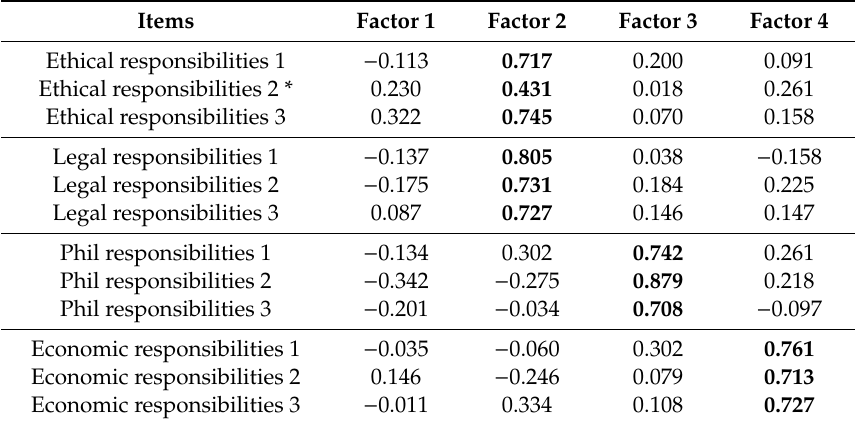
Table 4. Factor analysis of the CSR dimensions.